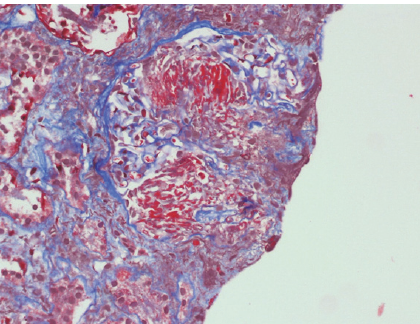
Figure 3: Tubular atrophy with dense lymphocytic inflammatory infiltrate and interstitial